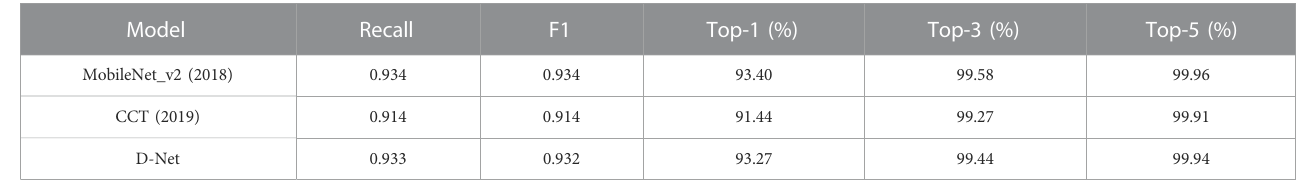
TABLE 5 Data comparison of D-Net on